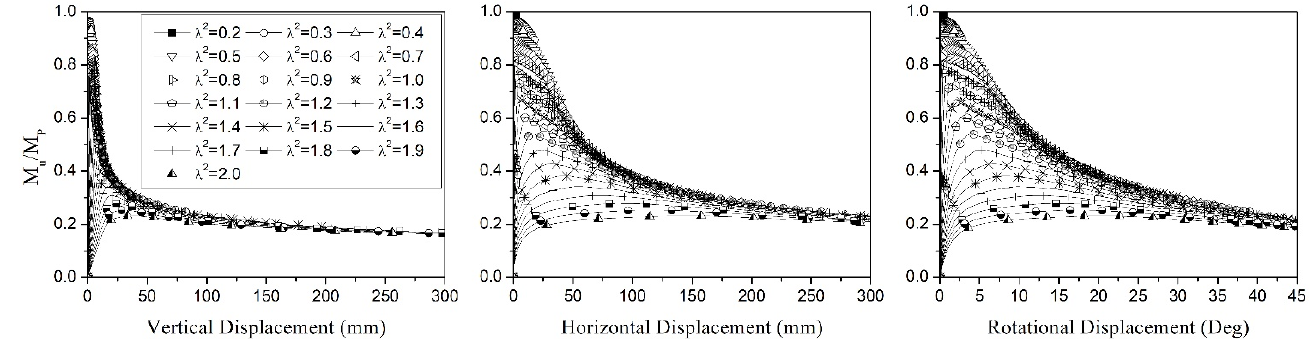
Figure 3. Load–Displacement Curve of Straight Girder—Sec#1.